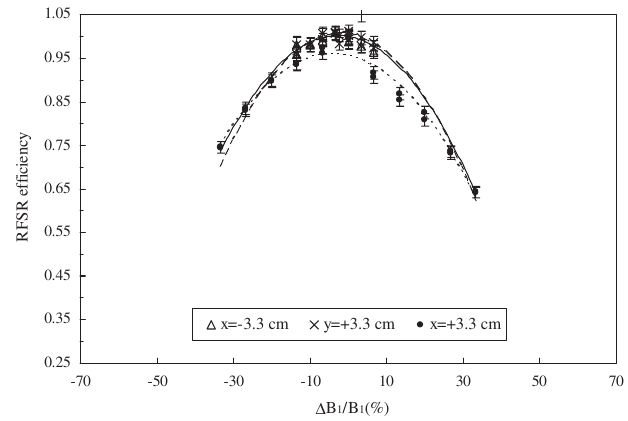
FIG. 10. The spin-flip efficiency of the RFSR on off-axis at x (cid:4) (cid:2) 3 : 3 cm (circle and triangle) and y (cid:4) (cid:8) 3 : 3 cm (cross) as a . The data are measured function of the rf field amplitude B 1 using the RFSR-flip method. The lines (short-dashed, medium- dashed, long-dashed lines) are quadratic fits to the data x (cid:4) (cid:3) 3 cm , and the long-dashed line to the y (cid:4) (cid:8) 3 cm position.